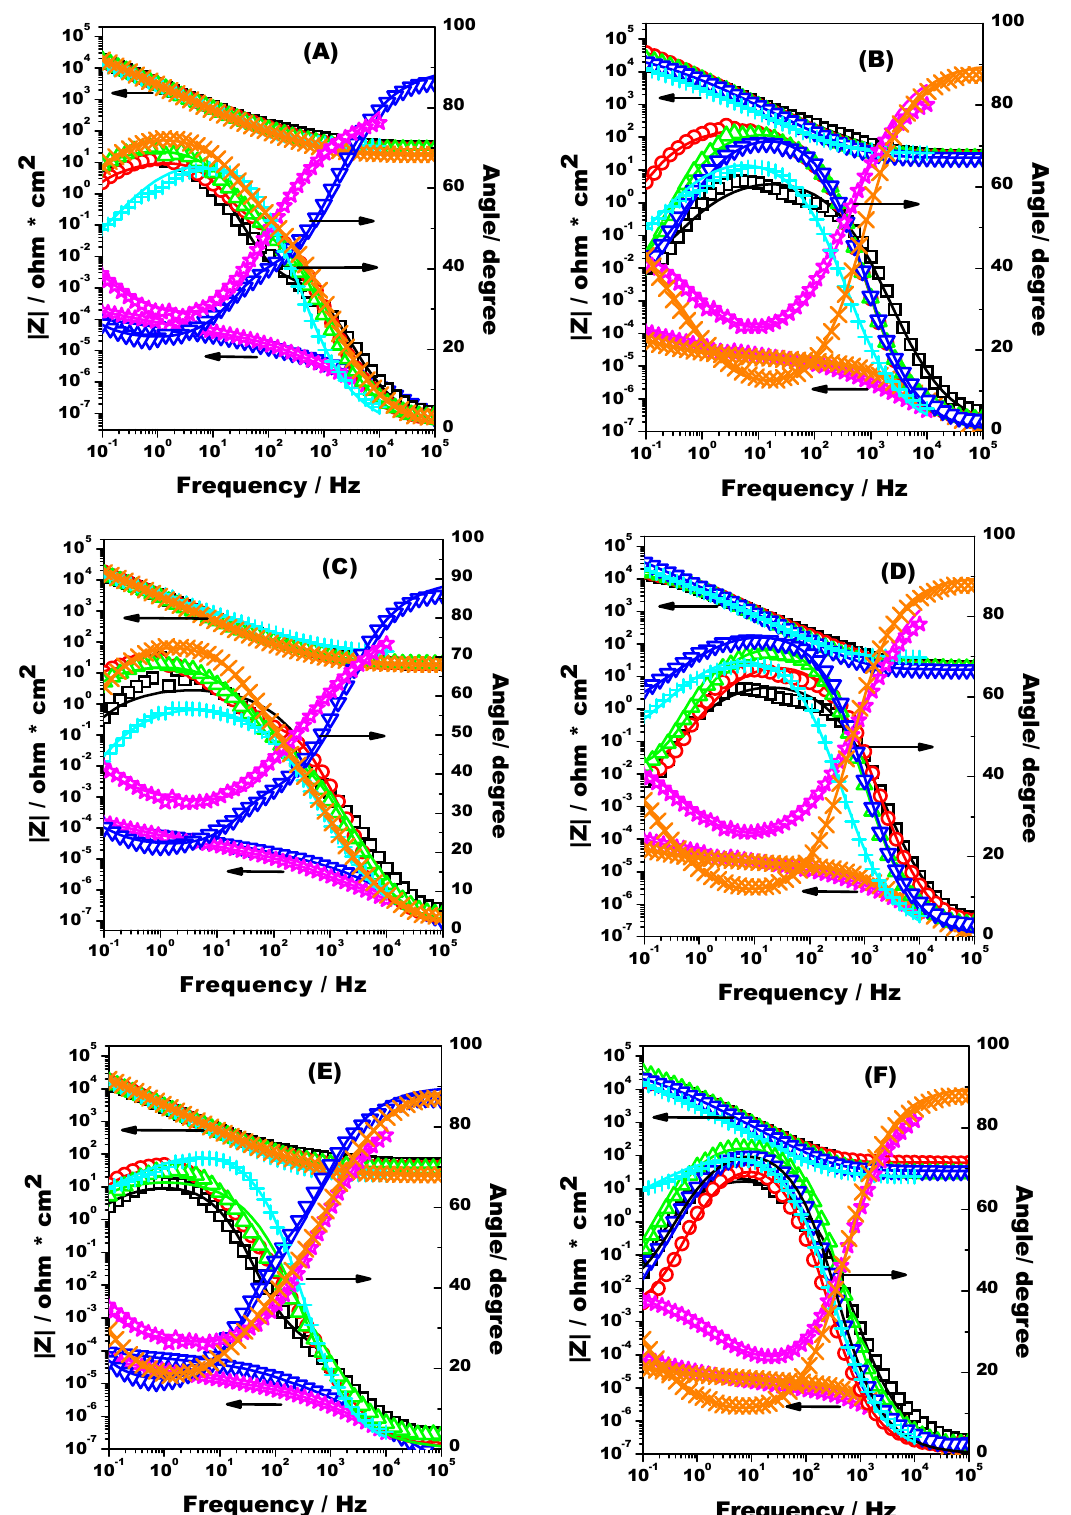
Figure 6. Bode diagram (log |Z| vs .log f and phase angle vs. log f) for measured data at Ni-Cr ( A , C , E ) and Co-Cr ( B , D , F ) bare electrodes ( + , cyan) and covered with ZrO 2 ( X , orange), S1 ( ∗ , magenta), S2 ( (cid:3) , black), S3 ( , red), S4 ( , green), S5 ( , blue) in chitosan membrane, recorded at the open circuit potential in artificial saliva of pH 4.3 (A, B), pH 5 (C, D), pH 6 (E, F) and the corresponding simulated data (solid line).